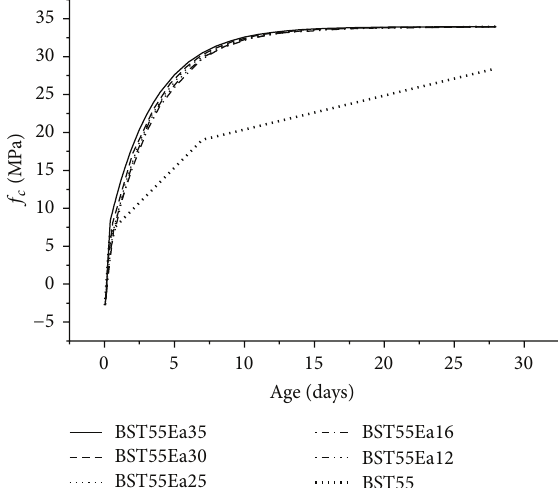
Figure 12: Simulation development of compressive strength with variation of energy of activation and experimental curves of sand concrete heat treated at 55 ∘ C.